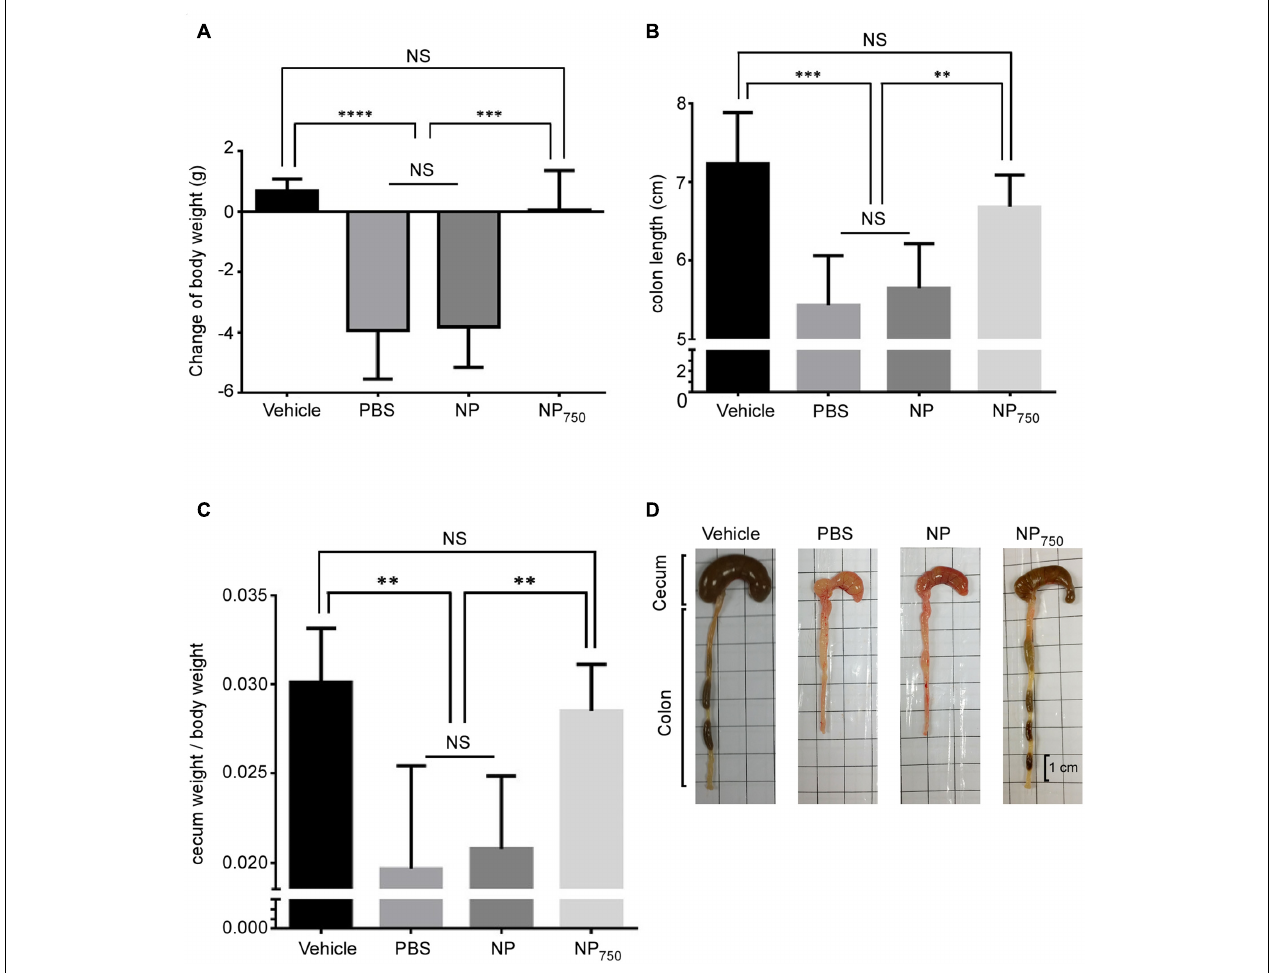
FIGURE 6 | Protection against purified C. difficile spores challenge in vaccinated mice. Various groups of mice were treated with an antibiotic cocktail and then challenged by C. difficile or PBS only for 2 days. Body weight change (A) , colon length (B) , cecum weight (C) , and gross views of cecum and colon (D) were assessed. Vehicle: non-immunized and non-infected group; PBS: mock-immunized and infected group; NP: empty nanoparticle immunized and infected group; NP 750 : vaccine immunized and infected group. All data are representative of at least three independent experiments. All data are presented as mean ± standard deviations and statistical comparisons among groups were analyzed by Student’s t-test ( ∗∗ p ≤ 0.01, ∗∗∗ p ≤ 0.001). NS = not